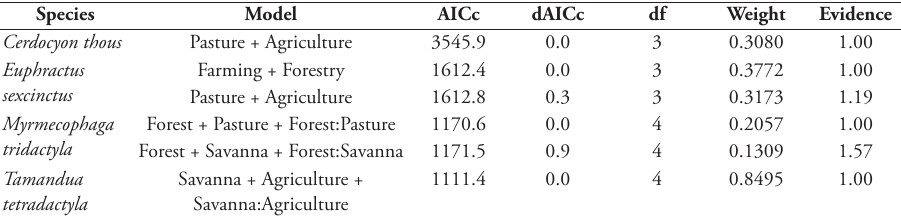
Table 1. Model selected by species according to Akaike criteria. dAICc represents the AIC distance; df represents degrees of freedom; weight represents how much the model explain de variables related to all other models; evidence is the highest weight model divided by the weight of the focal model. We just considered models with evidence lower or equal to